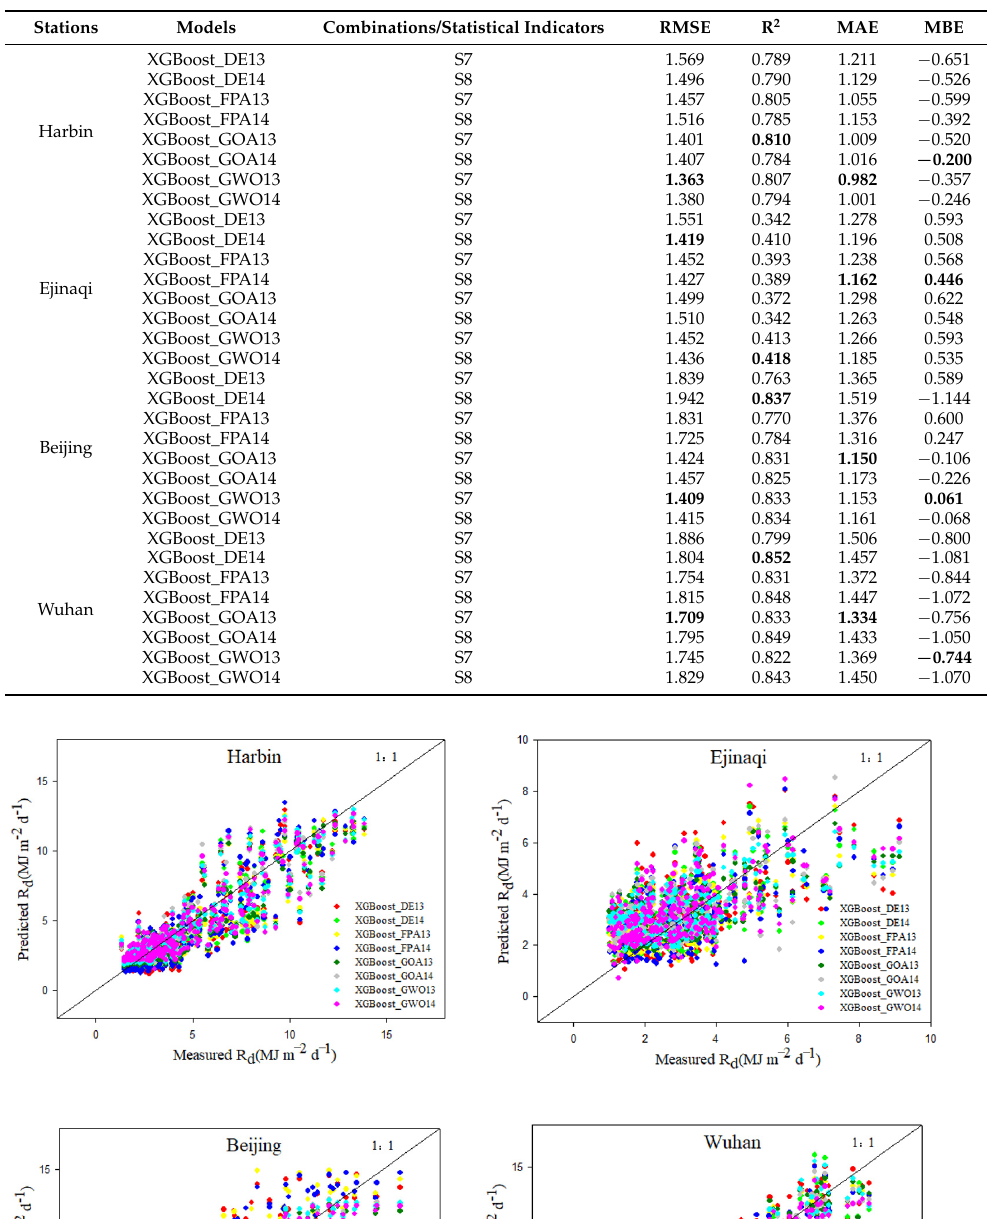
Table 8. Statistical results of XGBoost_DE, XGBoost_FPA, XGBoost_GOA, and XGBoost_GWO models for simulating R d in Mohe, Urumqi, Shengyang, and Zhengzhou stations based on satellite data at Harbin, Ejinaqi, Beijing, and Wuhan stations.